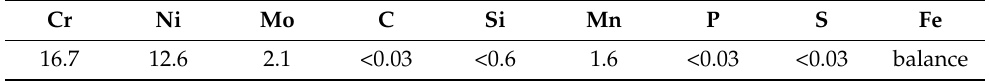
Table 1. Chemical composition of AISI 316L austenitic stainless steel (wt.%), adapted from ref. [33]. Cr